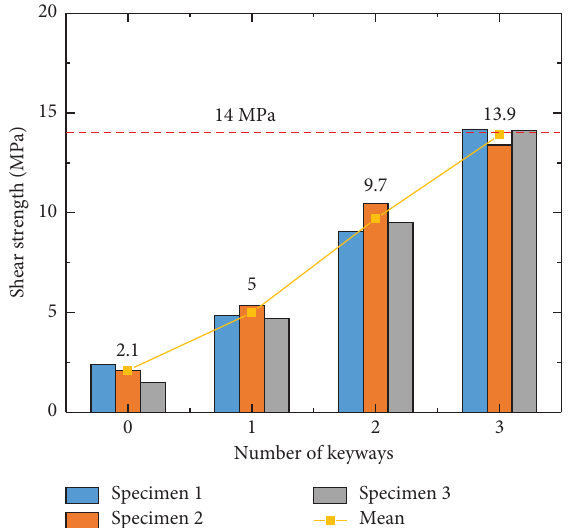
Figure 7: Interfacial bond shear strength with diferent number of keys.